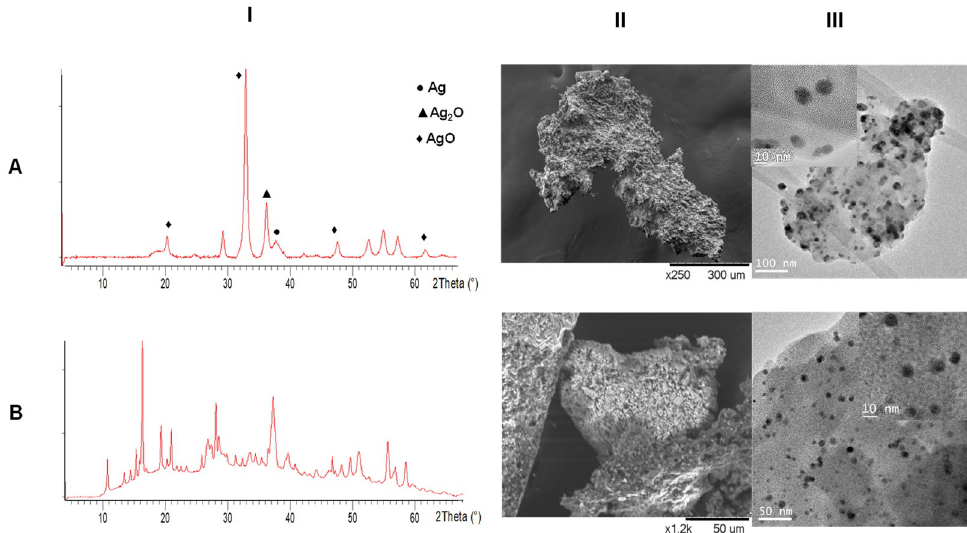
Figure 5. ( A ) AgNPs@CATb hybrid characterization; ( B ) PdNPs@CATb hybrid characterization. (I)